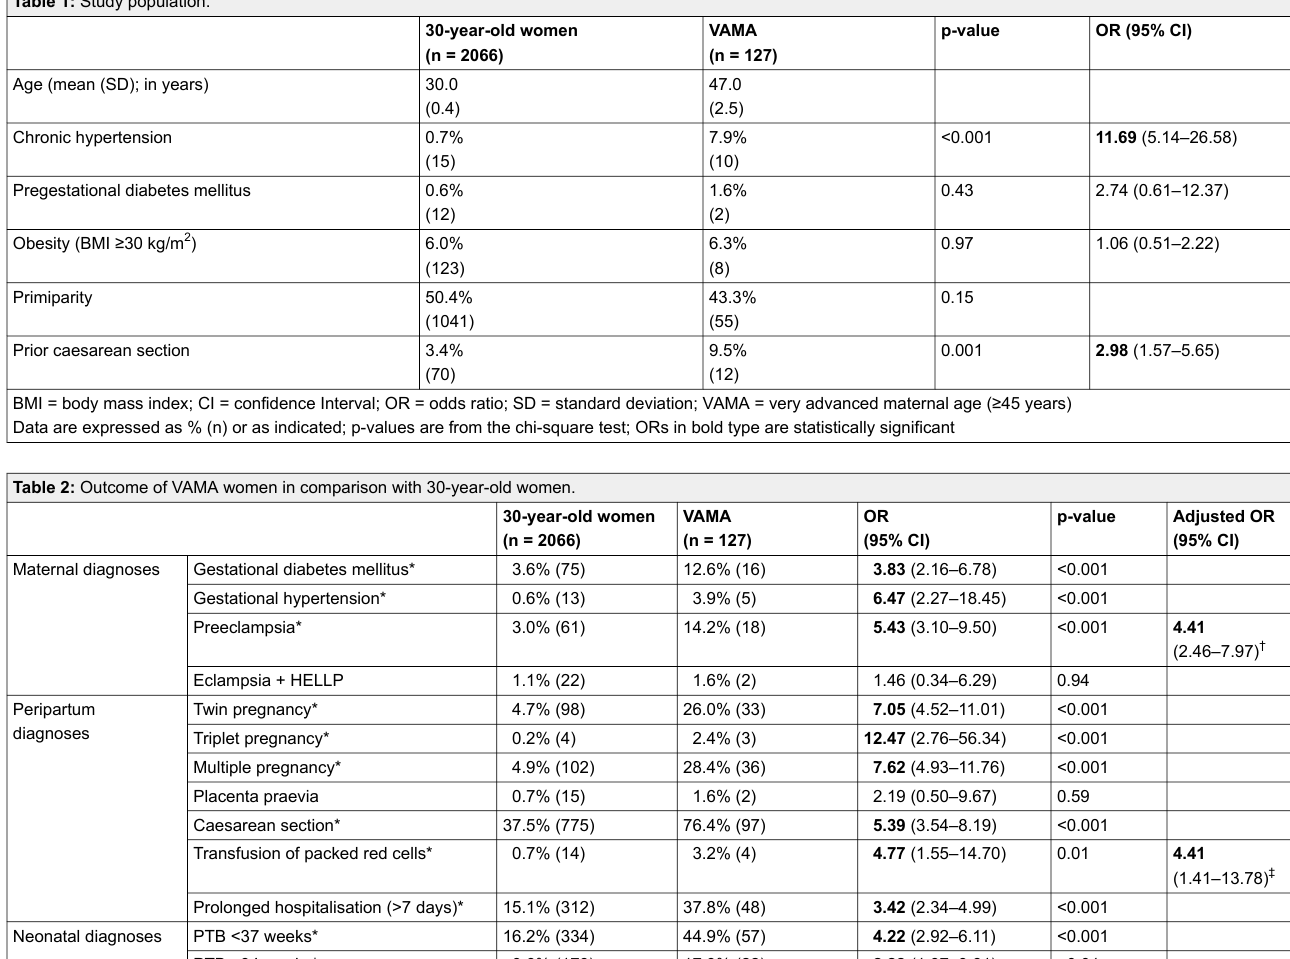
Table 1: Study population.